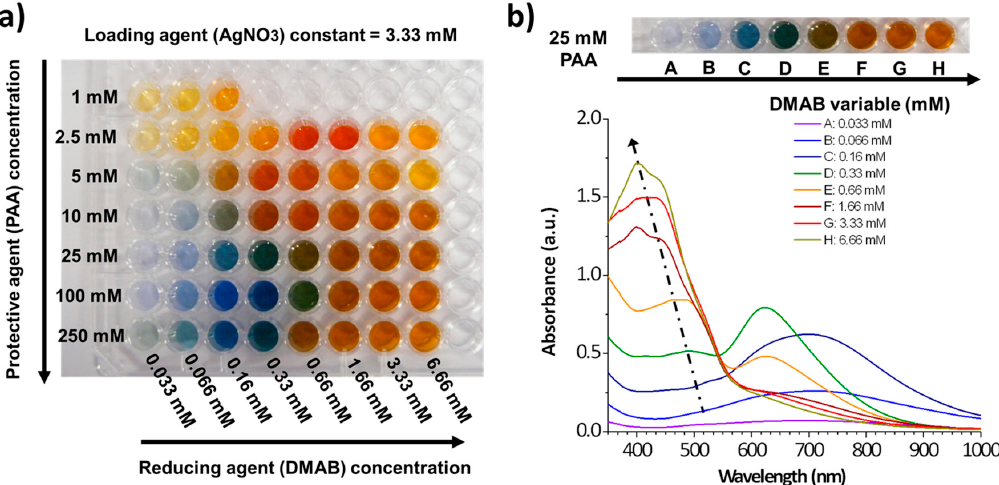
Figure 12. ( a ) Photograph of the multicolor silver map obtained as a function of variable protective agent (PAA from 1mM to 250 mM) and reducing agent (DMAB from 0.033 to 6.66 mM), respectively. ( b ) UV-Vis spectra of the silver solutions prepared with variable DMAB concentration at a constant PAA concentration of 25 mM (fifth line of the multicolor silver map). Reproduced from [129] with permission; Copyright Springer 2013.